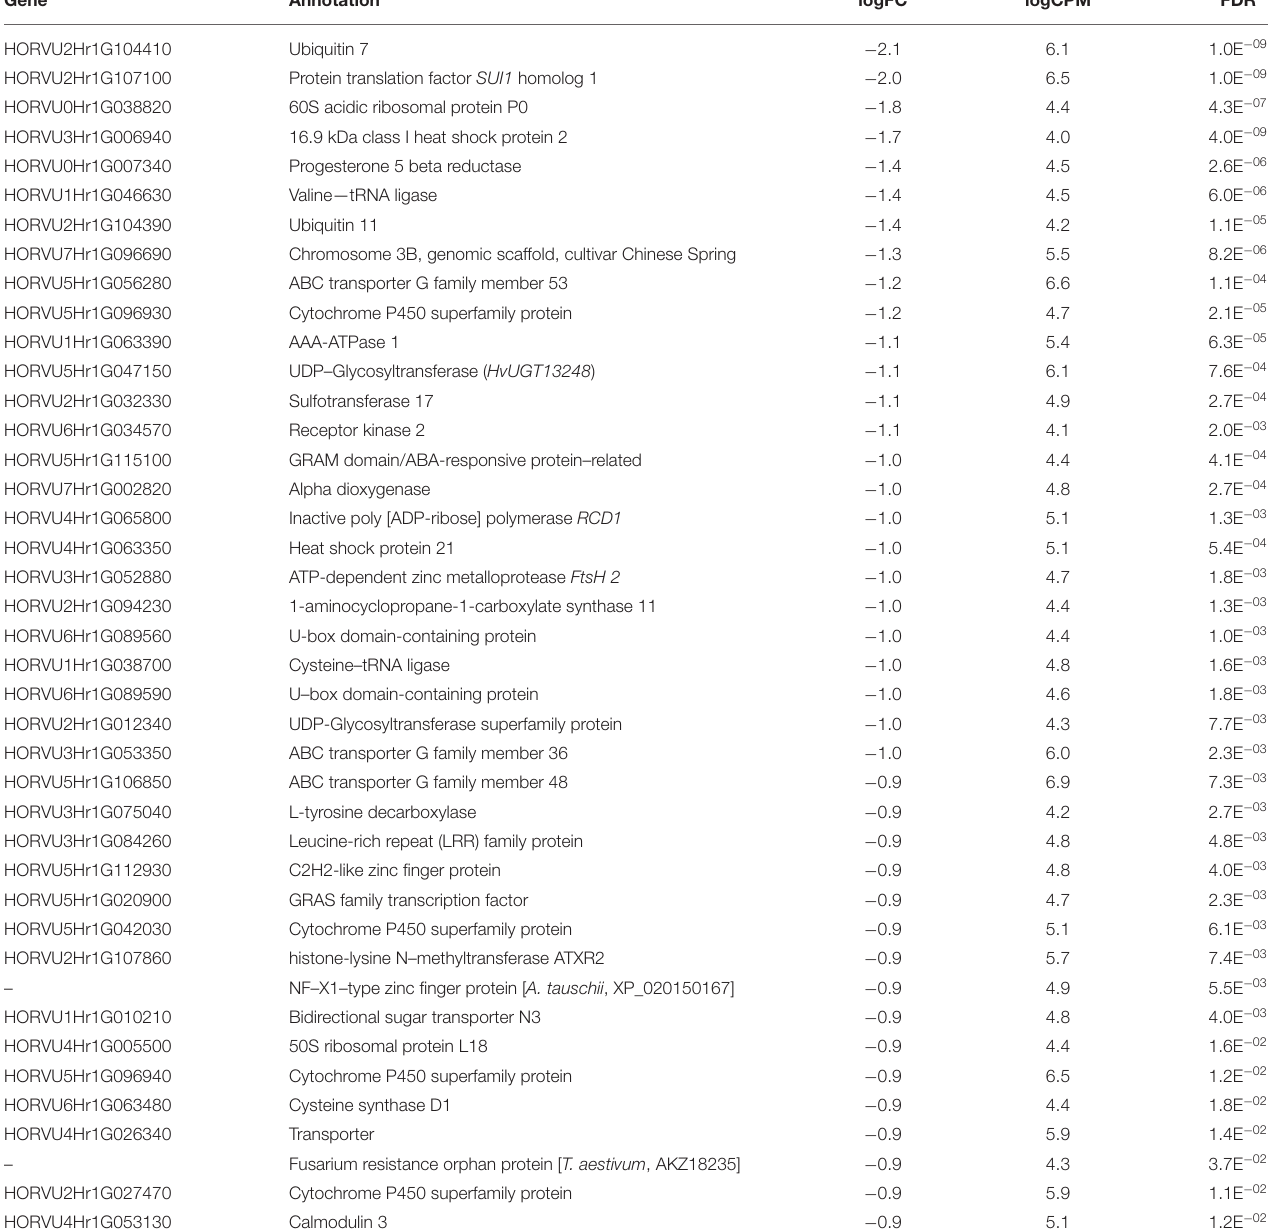
TABLE 5 | Transcript alterations in select upregulated genes from 72- to 96-h post-infection identified in the additive, interactive generalized linear model.